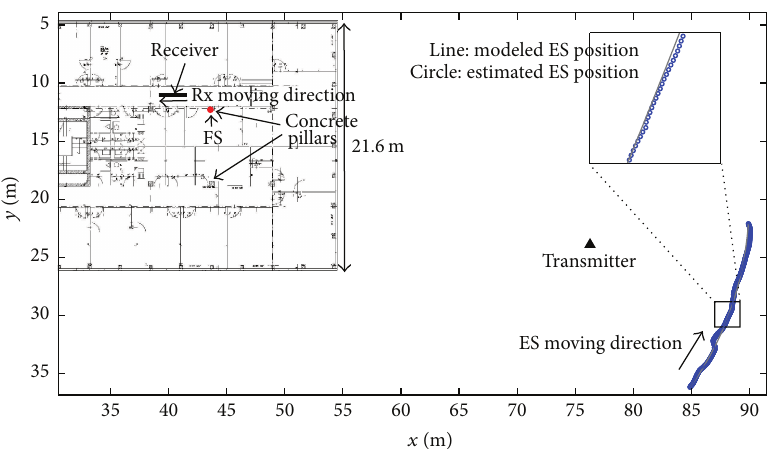
Figure 7: An example of the estimated positions of ES and FS for Scenario-1.